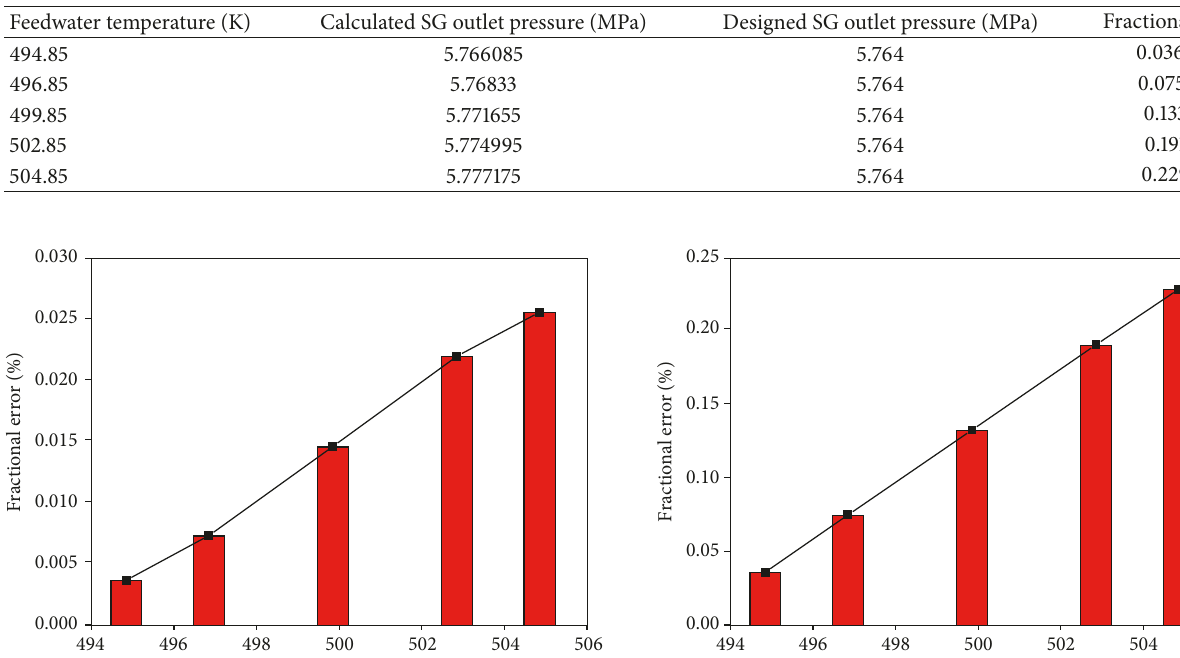
Table 16: The influence of feedwater temperature on the SG outlet pressure.